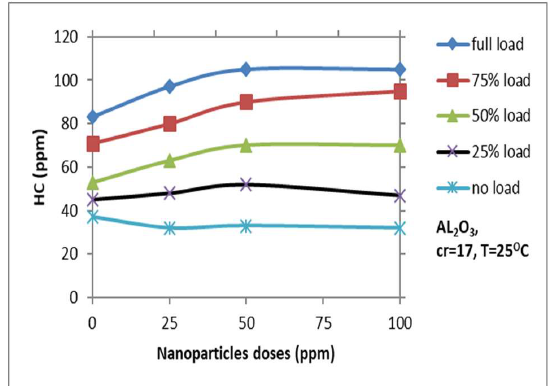
Fig. 8. Variation of Carbon dioxide Emissions (CO 2 ) with Alumina nanoparticles doses.